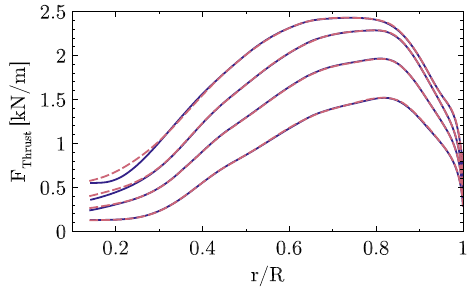
Figure 36. Influence of different wind speeds on the sectional driv- ing force. CaseT1.0 (solid), CaseT1.0-fairing